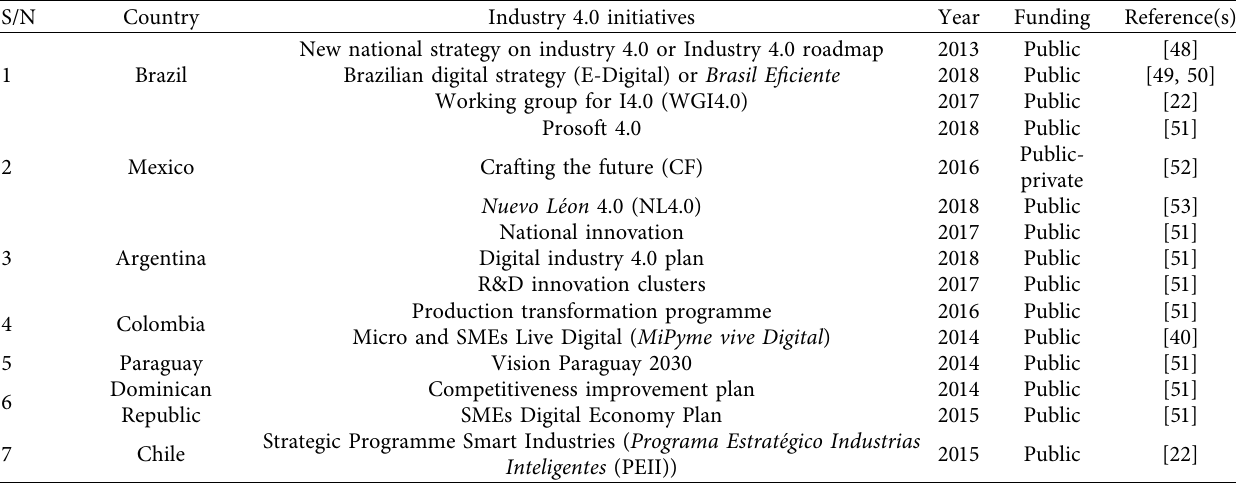
Table 1: Industry 4.0 initiatives in Latin America and the Caribbean.